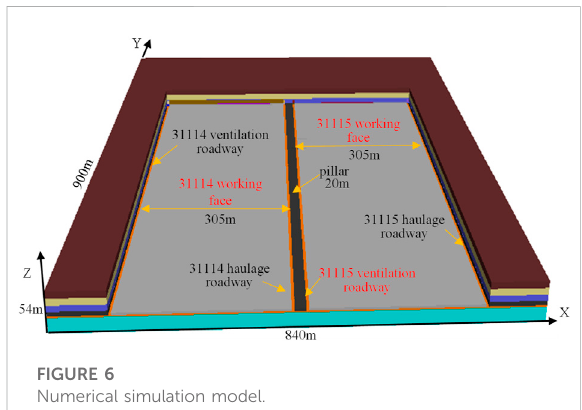
FIGURE 6 Numerical simulation